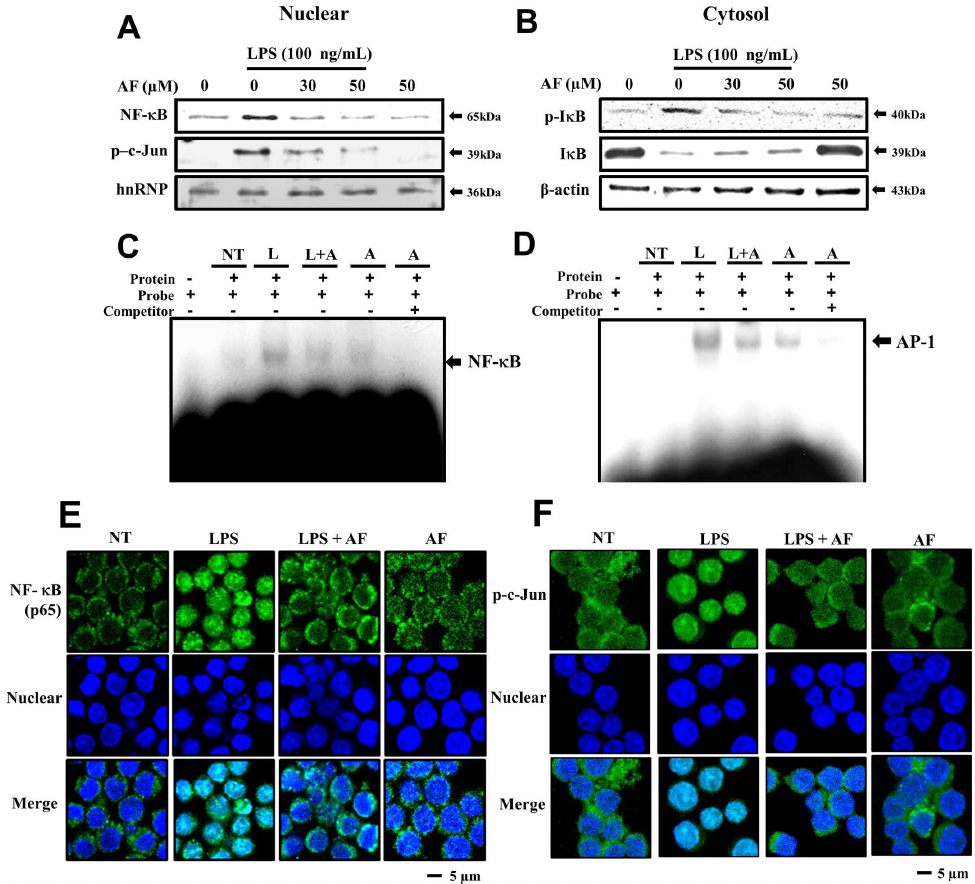
Fig 5. Effects of AF on LPS-induced nuclear translocation of NF- κ B and AP-1 in RAW 264.7 macrophage cells. Cells were treated in the presence or absenceof variousconcentrations (0–50 μ g/ml) of AF for 30 min and further incubatedwith or without 100 ng/ml of LPS for 15 min. Then, the cells were harvested and separatedinto nuclear(A) and cytosolic extracts (B), as describedin the Methods section. The protein extracts were separated on SDS-PAGE gels and immunoblotted using Western blot analysis. The antibodiesused were anti-NF- κ B,-p-c- Jun, -hnRNP, -I κ B, and - β -actin. hnRNP and β -actinwere used as controls for nuclear-and cytosol-specific proteins, respectively.(C), (D) EMSA showingthe reductionin NF- κ B and AP-1 DNA bindingactivity in nuclear proteins. Cells were preparedby stimulation with 100 ng/mL LPS for 15 min and pre-treatedwith 50 μ M AF for 30 min. (E), (F) The translocation of NF- κ B (p65) and AP-1 to the nucleus was analyzedby confocalmicroscopy. Macrophages were immunostained using FITC for NF- κ B and AP-1 and Hoechst to label nuclei. White scale bars, 5 μ m. NT, no treatment; A, AF; L, LPS; L+A, LPS with